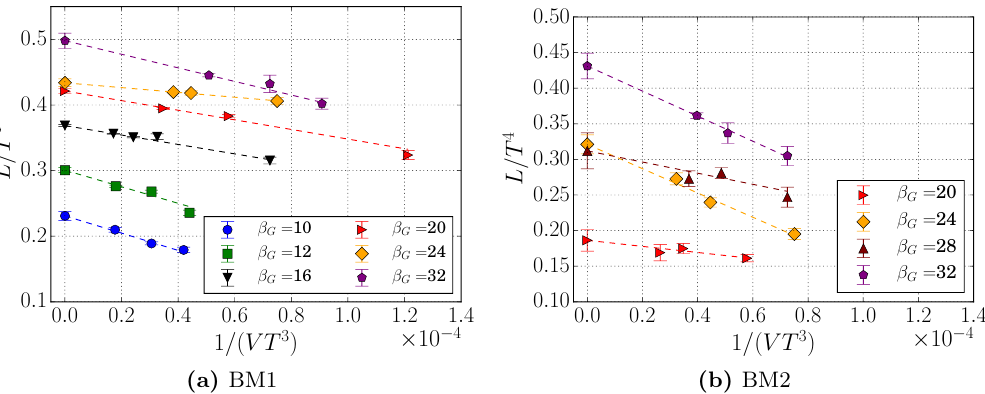
Figure 6. In(cid:12)nite-volume extrapolation of the latent heat.